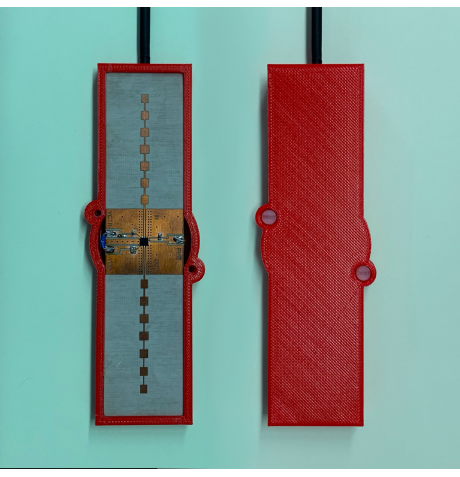
Figure 4. Photography of modulating transponder